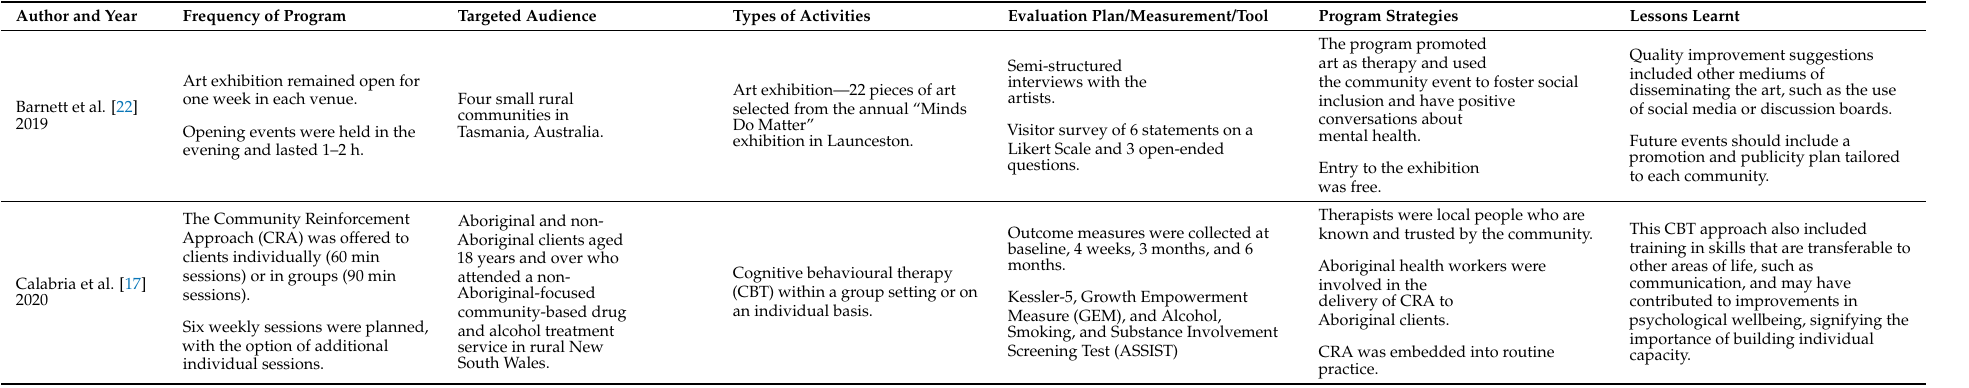
Table 4. Characteristics of suicide prevention